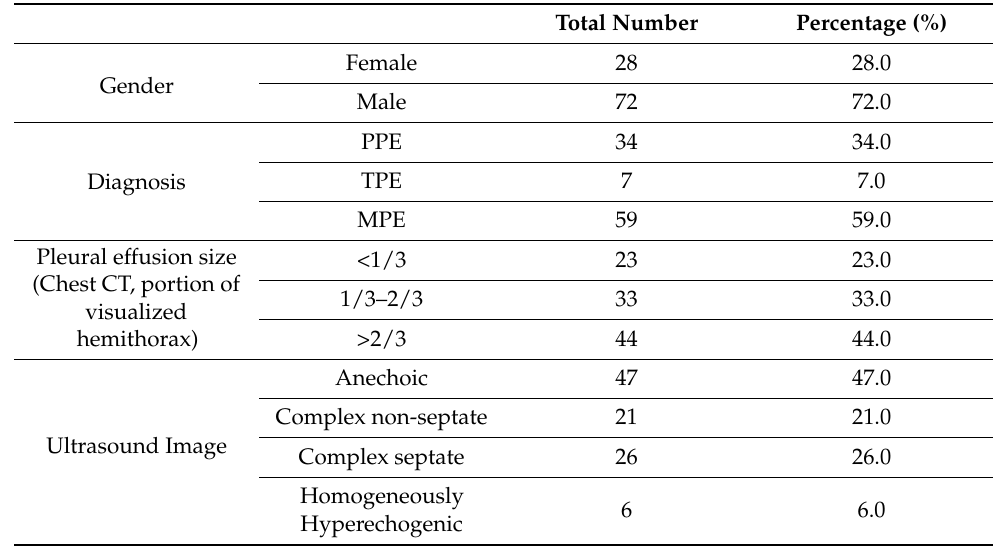
Table 1. Patient Characteristics.